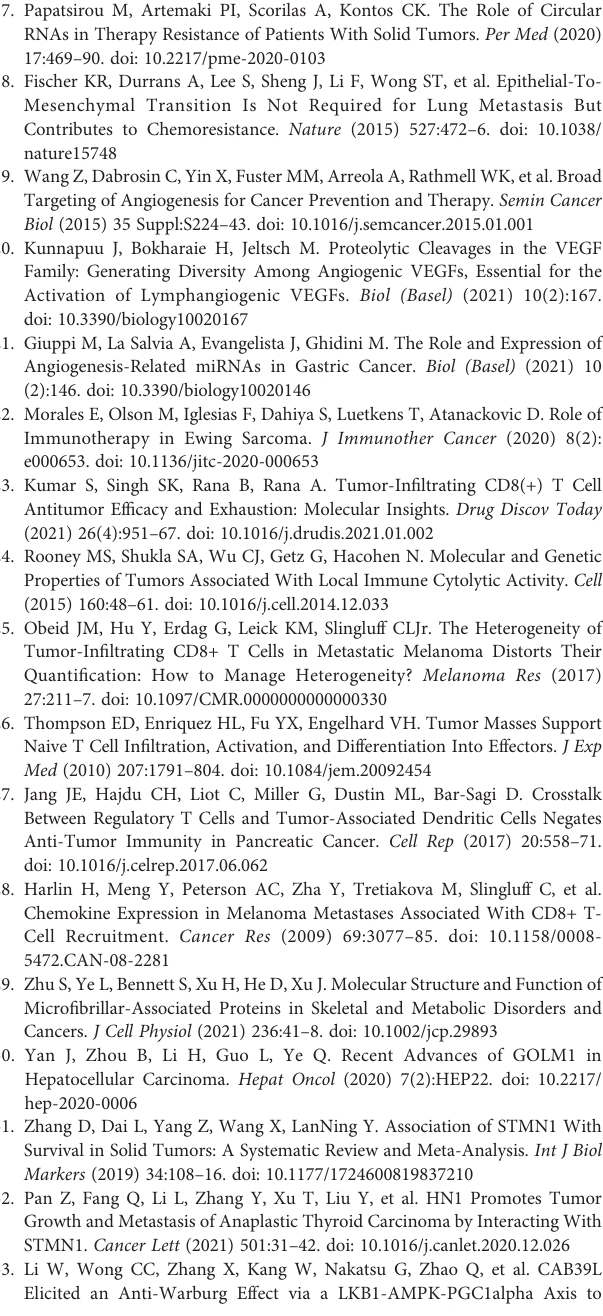
Supplementary Figure 2 | GSEA map of EC and CS. GSEA of immunologic signature gene sets in EC and CS. Supplementary Figure 3 | The distant recurrence-free survival suggesting the prognostic factors. (A-F) The distant recurrence-free survival using Prognoscan. Red and blue represent high and low expression level groups of MFAP2 (A) , GOLM1 (B) , STMN1 (C) , and HN1 (D) , CAB39L (E) and GAB2 (F)